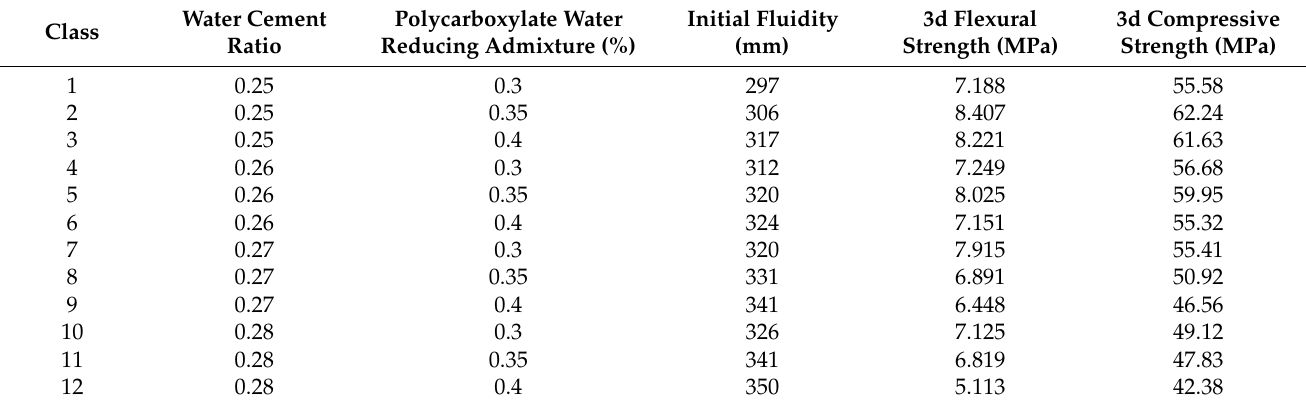
Table 7. Results of workability test of grouting materials with different water cement ratio.